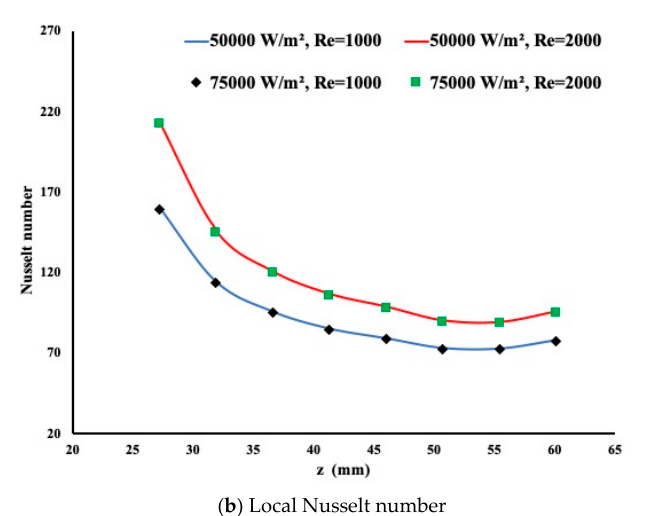
Figure 6. Temperature and the Nusselt number at the inner wall surface with twisted tape insert.